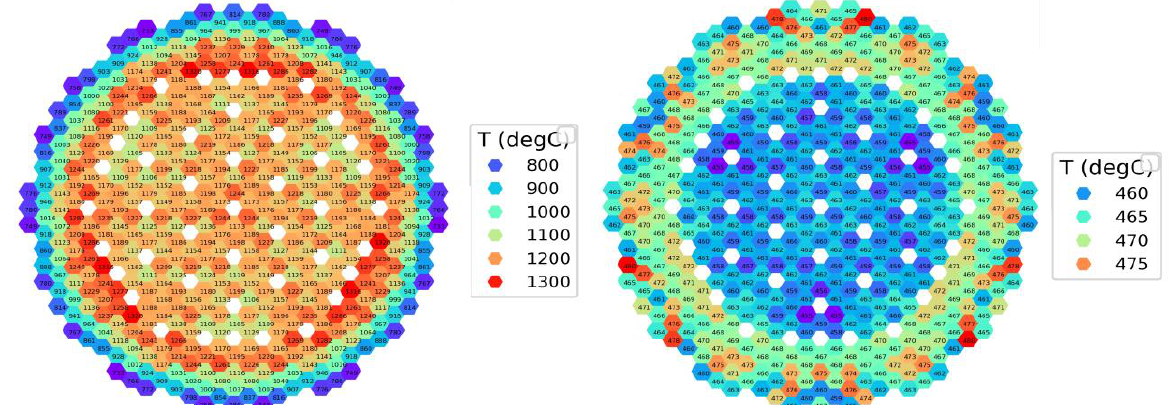
Figure 3. Percentage variation in power distribution at EOEC for ESFR-SMART core, calculated with and without thermal feedback